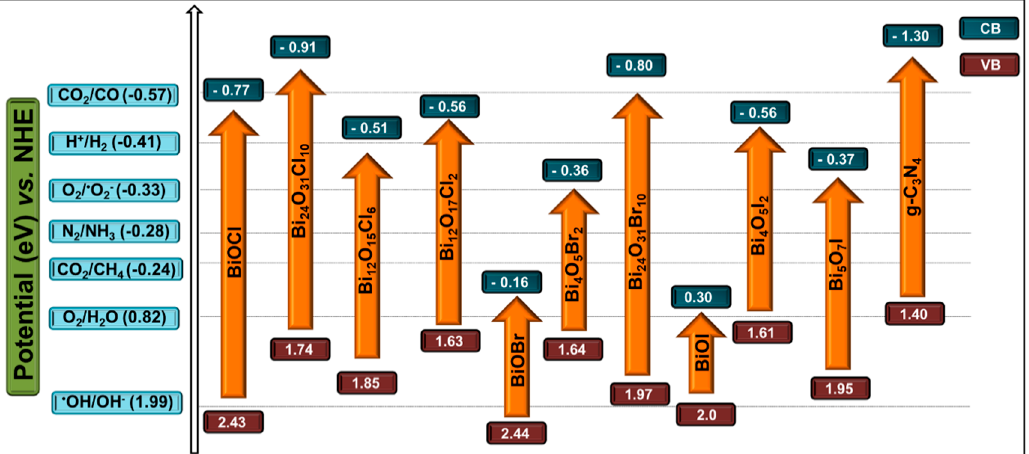
Figure 3. Conduction and valence band (CB and VB) positions of g-C 3 N 4 , BiOX, and some of the Bi x O y X z photocatalysts vs. Normal Hydrogen Electrode (NHE) at pH = 7. The redox potentials of different chemical reactions are compared in this figure.